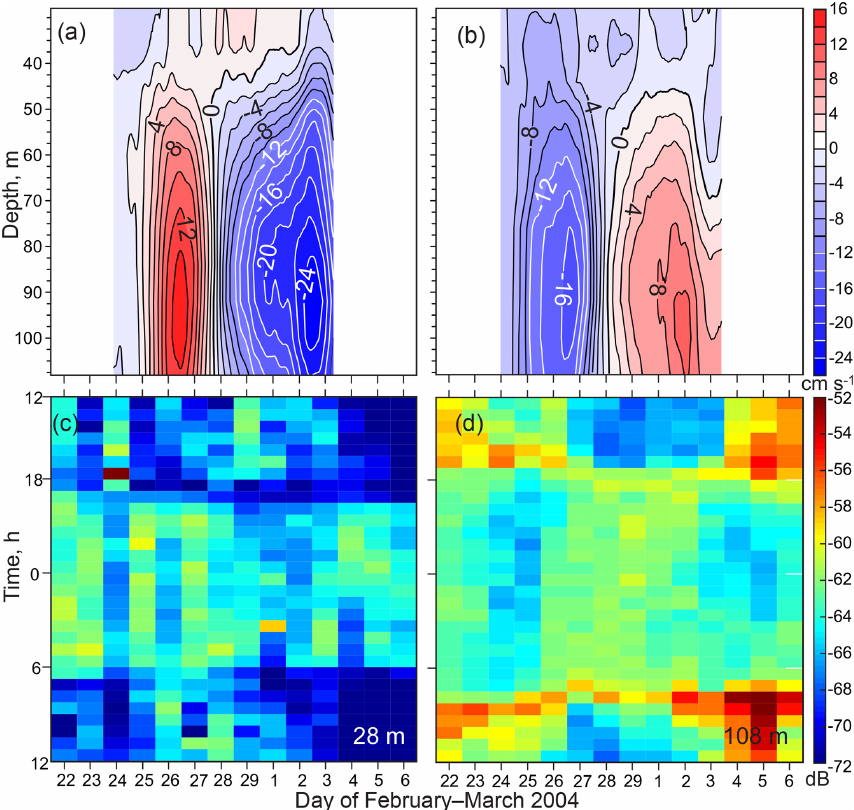
Figure 10. Enlarged view of the February–March 2004 eddy. (a) Zonal and (b) meridional current (cms − 1 ) records as functions of depth adopted from Dmitrenko et al. (2018). (c–d) Actograms of MVBS (dB) for (c) 28 and (d) 108m of